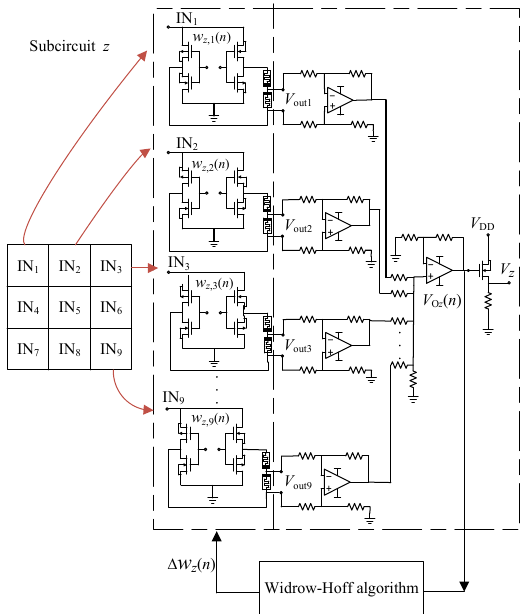
Figure 5. Schematic diagram of neuron circuit of z .